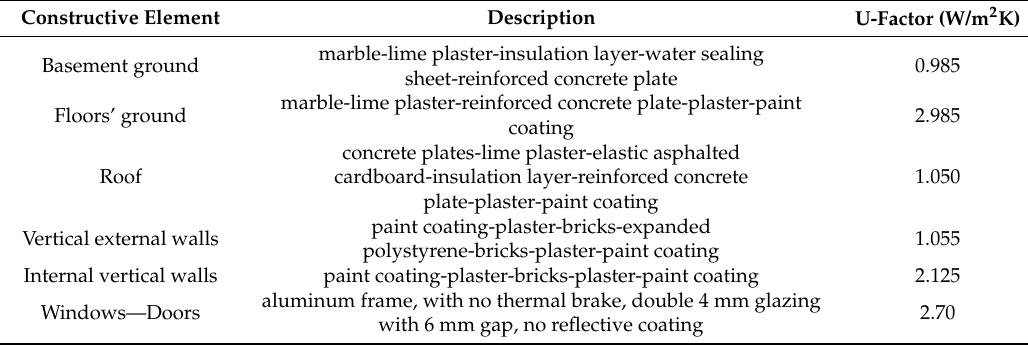
Table 2. Constructive features and U ‐ factors of the building’s envelope.